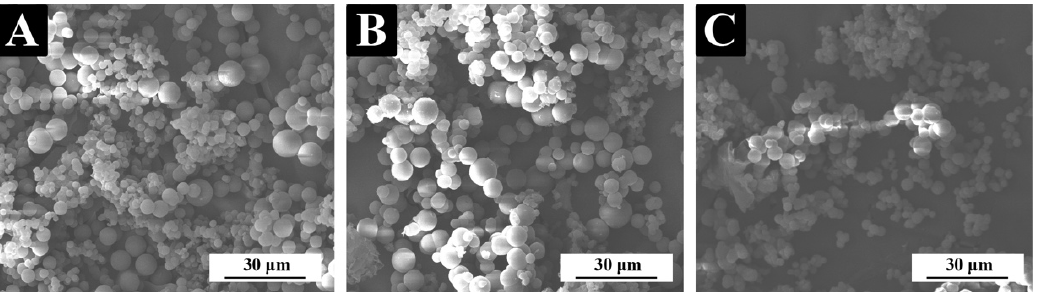
Figure 1. SEM images of ( A ) transparent shellac microcapsules; ( B ) purple shellac microcapsules; ( C ) yellow shellac microcapsules.